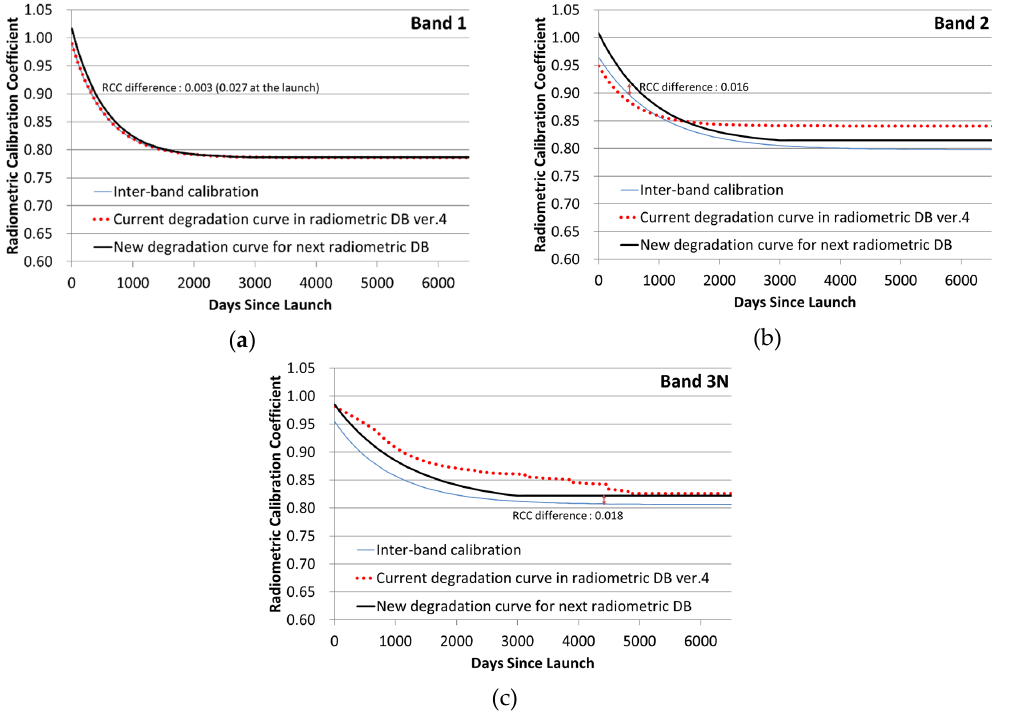
Figure B1. Comparison of the shape of the degradation curve calculated from the inter-band calibration, the current radiometric DB ver.4, and the next radiometric DB. Bands ( a ) 1, ( b ) 2, and ( c ) 3N.